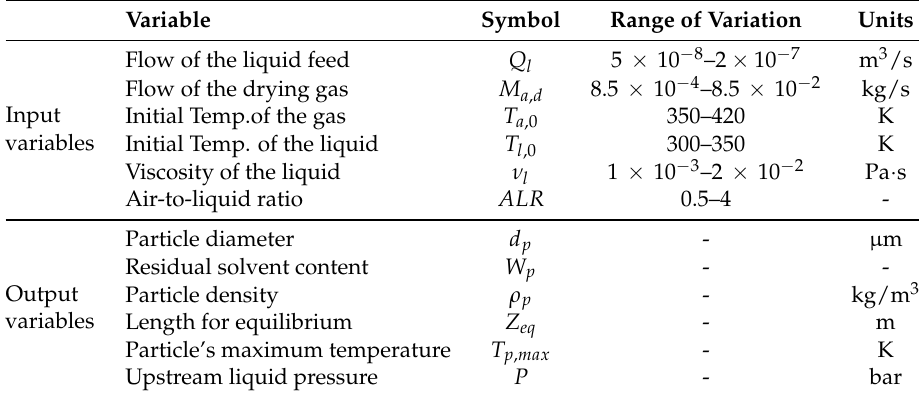
Table 1. Input and output variables considered for the sensitivity analysis with their ranges. Viscosity and upstream liquid pressure are considered only for the pressure nozzle, while ALR is considered only for the pneumatic